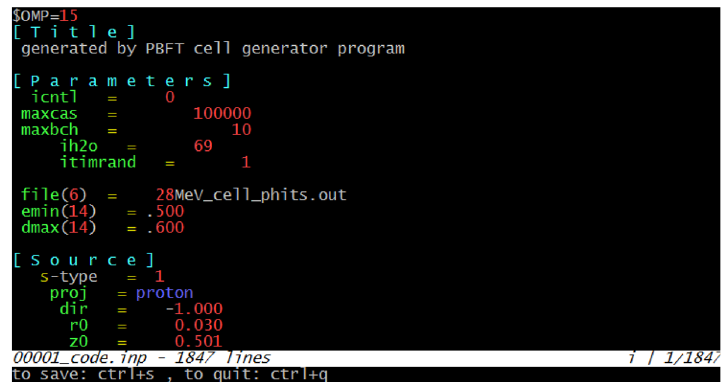
Figure 4. PHITS code editor program with PHITS syntax highlighting and line numbering in action.